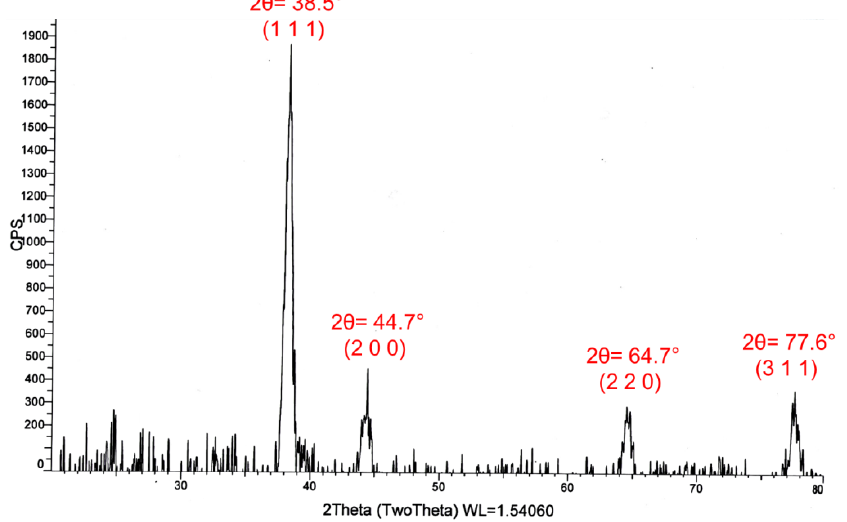
Figure 5. Xray difraction (XRD) pattern of sample 1 (S1), showing the face centered cubic (FCC) crystalline metallic silver nanoparticles (AgNPs) . The intesity in vertical axis is mearred in counts per second (CPS) and diffraction angle (2 theta) measred is taken along horizental axis. The value of wavelngth (WL in angstrom) is also mentioned in the figure .